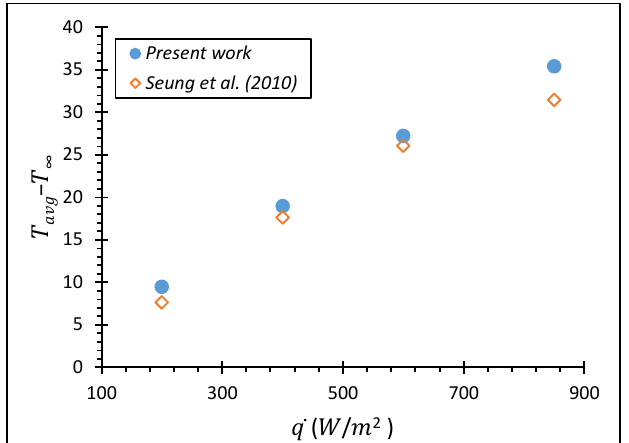
Figure 5: Comparison of temperature difference between the numerical results and experimental result.